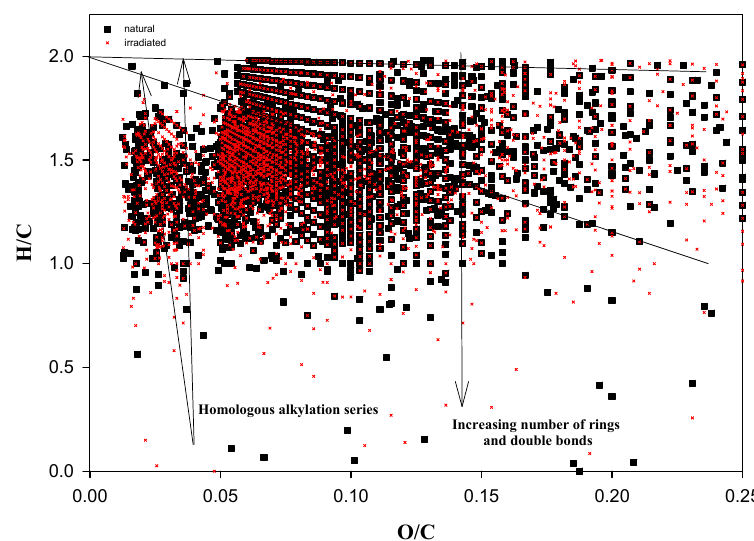
Figure 3. van Krevelen plot of the O 3 species found in natural ( ■ ) and irradiated oil ( X ). The compounds in homologous series, corresponding to varying degrees of alkylation, appear along lines that intersect the value of 2 on the H/C axis. Similarly, a vertical line connects homologous series differing in degree of unsaturation.